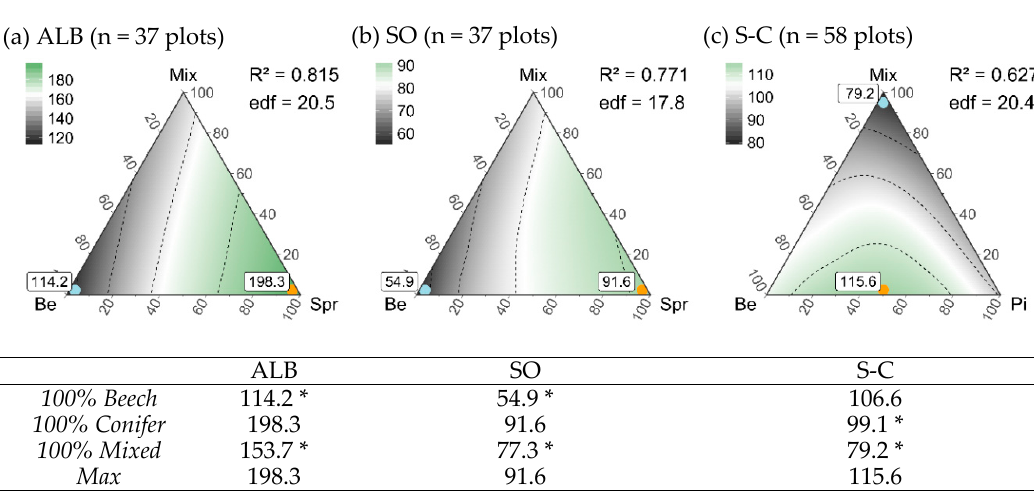
Figure A3. Gamma diversity (species richness) of vascular plants along compositional gradients of pure beech (Be), pure conifer (Pi = Pine, Spr = Spruce) and mixed stands (Mix) in ( a ) Schwäbische Alb (ALB), ( b ) Solling (SO) and ( c ) Schorfheide-Chorin (S-C). Stand type composition varied in steps of 10% using 1000 resamplings of 37 (ALB, SO) and 58 plots (S-C) per step (66 unique compositions), the maximum number of plots allowing for more than 1000 resamplings at each corner of the triangle. The diversity response to composition is characterized by R 2 and estimated degrees of freedom (edf). Labelled dots mark the maximum (orange) and minimum (light blue). Numbers below the triangles show gamma diversity values for 100% beech stands, 100% conifer stands (either spruce (Spr) or pine (Pi)), 100% mixed stands and the composition of stand types supporting maximum gamma diversity (Max). * mark significant differences to the maximum gamma diversity.